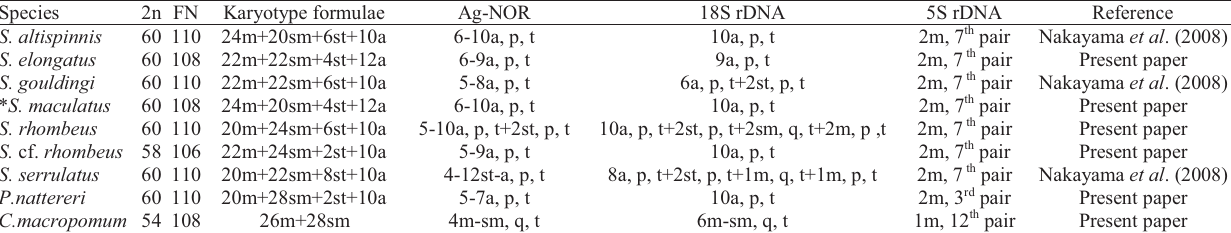
Table 1. Karyotype characteristics in the studied species of Serrasalmidae. 2n = modal diploid number; m = metacentric, sm = submetacentric, st = subtelocentric, a = acrocentric chromosomes; FN = fundamental number; p = short arm; q = long arm; t = terminal; Ag-NORs = nucleolar organizer regions stained with silver nitrate; 18S rDNA = maximum number of sites detected by FISH; 5S rDNA = number of sites detected by FISH. * S. maculatus = S. spilopleura cytotype A (according to Nakayama et al. , 2000; Centofante et al. ,